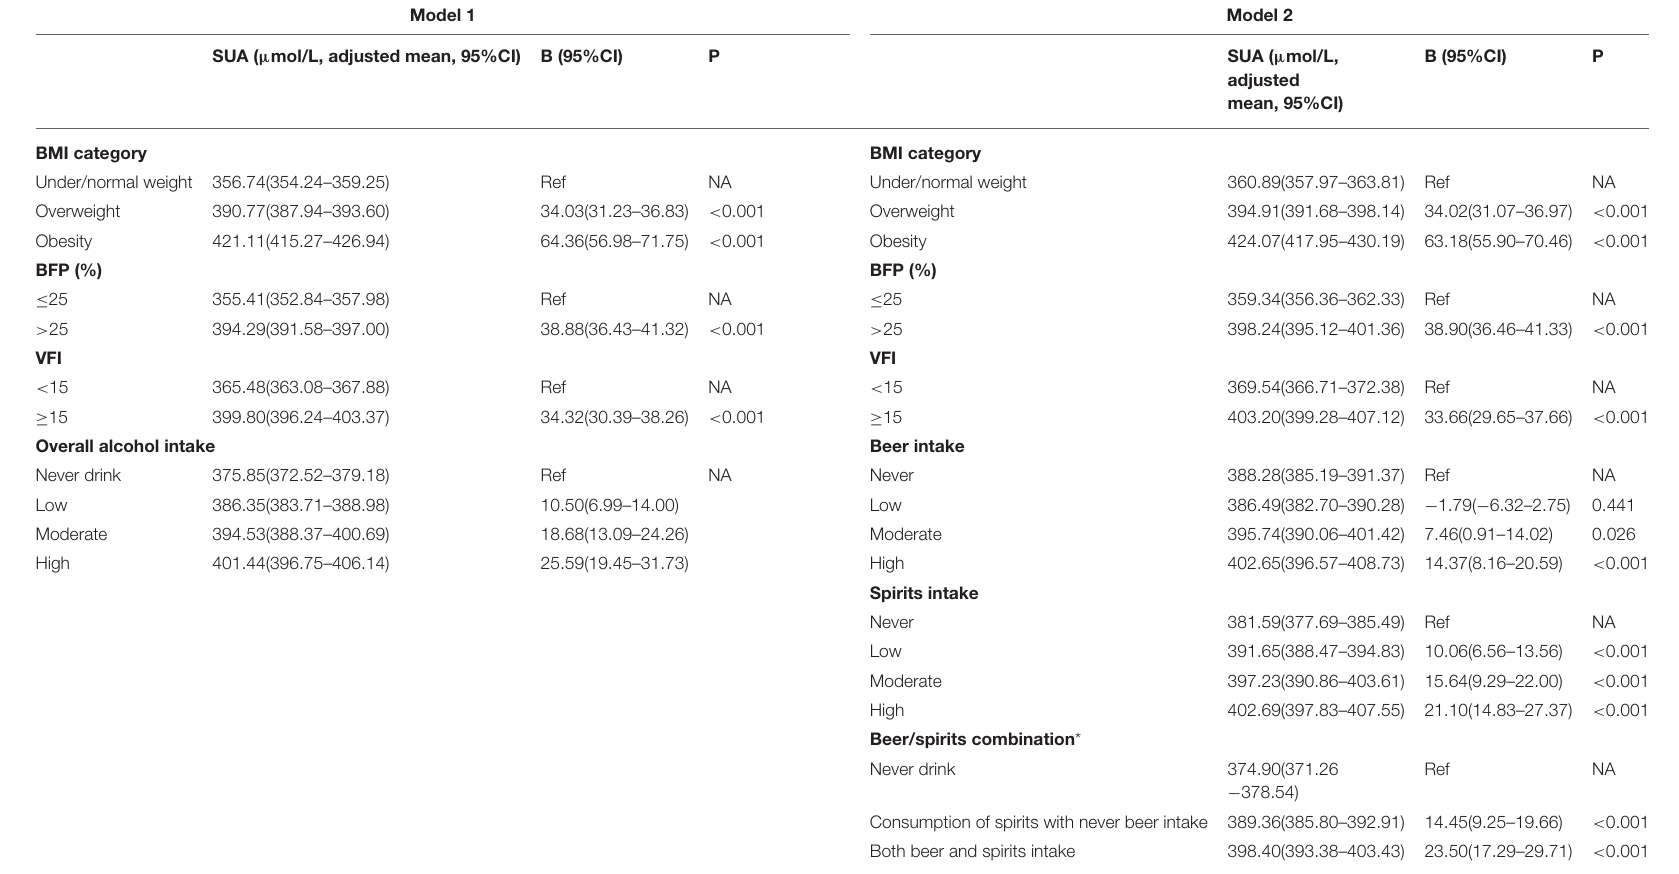
TABLE 2 | Adjusted serum uric acid (SUA) levels in stratified groups and the effect of excess adiposity, beer, and spirits intake on SUA ( n = 12,592). Model 1 Model